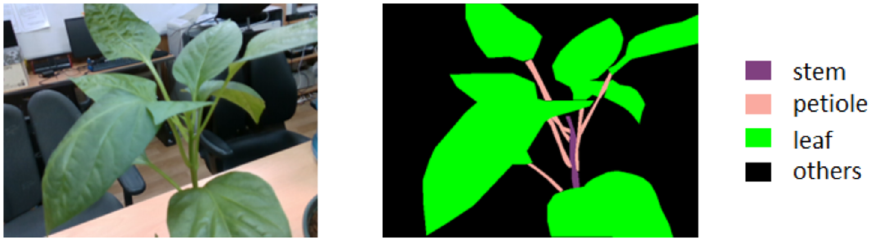
Figure 1. An example of sweet pepper labeling.